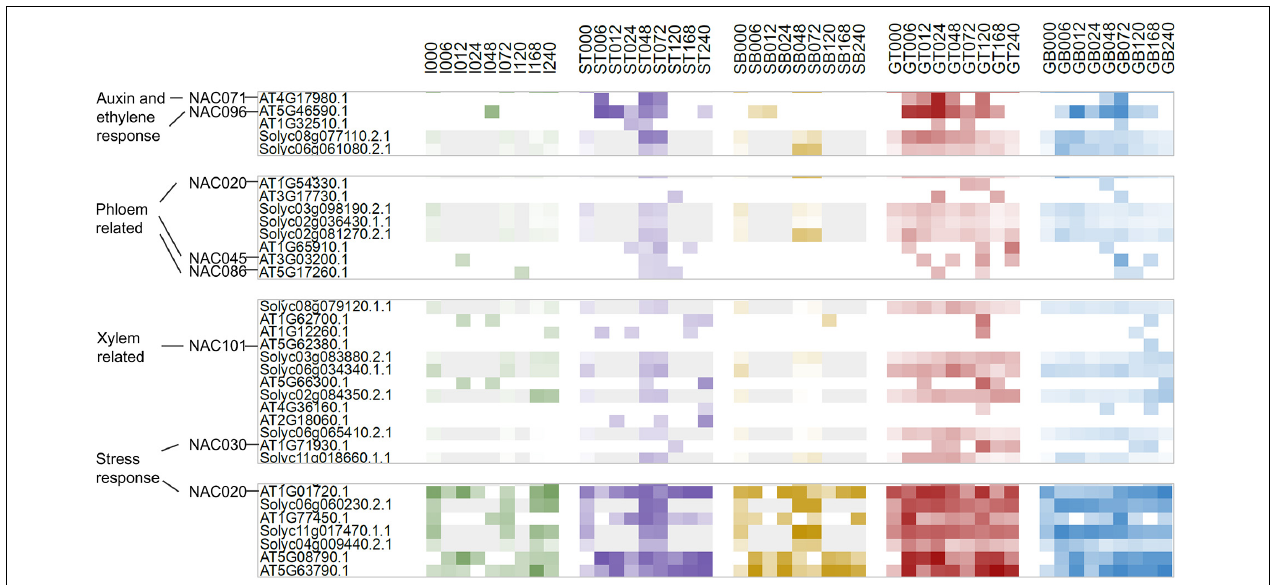
FIGURE 4 | Cluster relationship and expression patterns of NAC